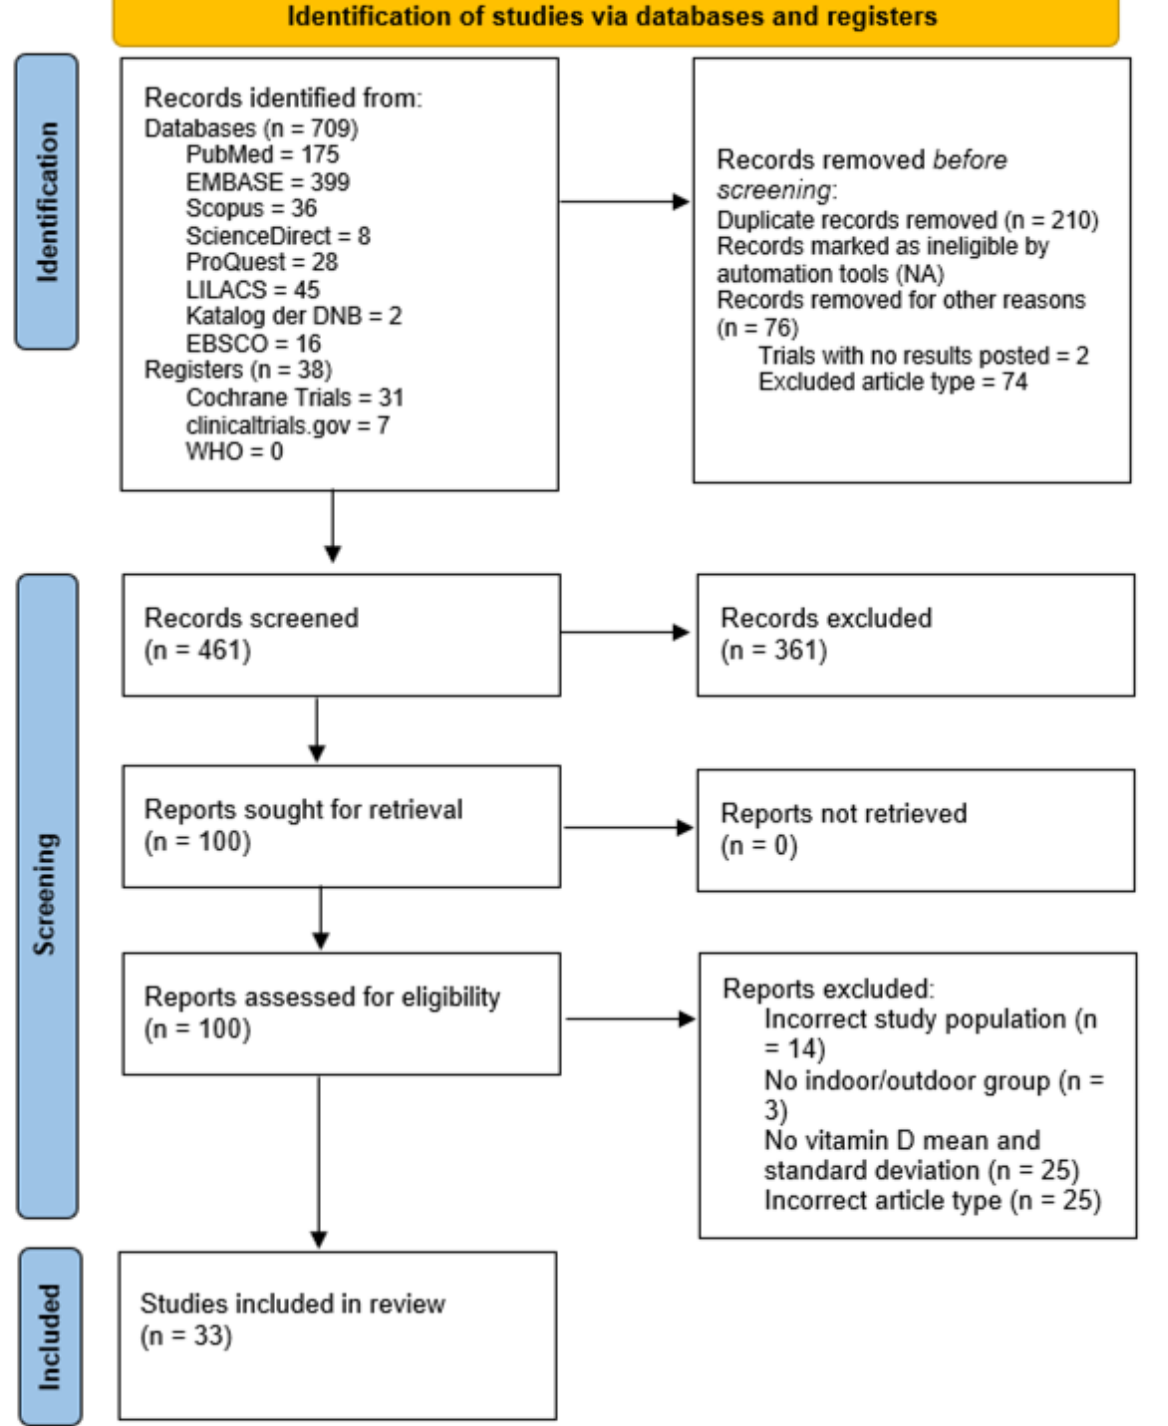
Figure 1. PRISMA flowchart for study selection.